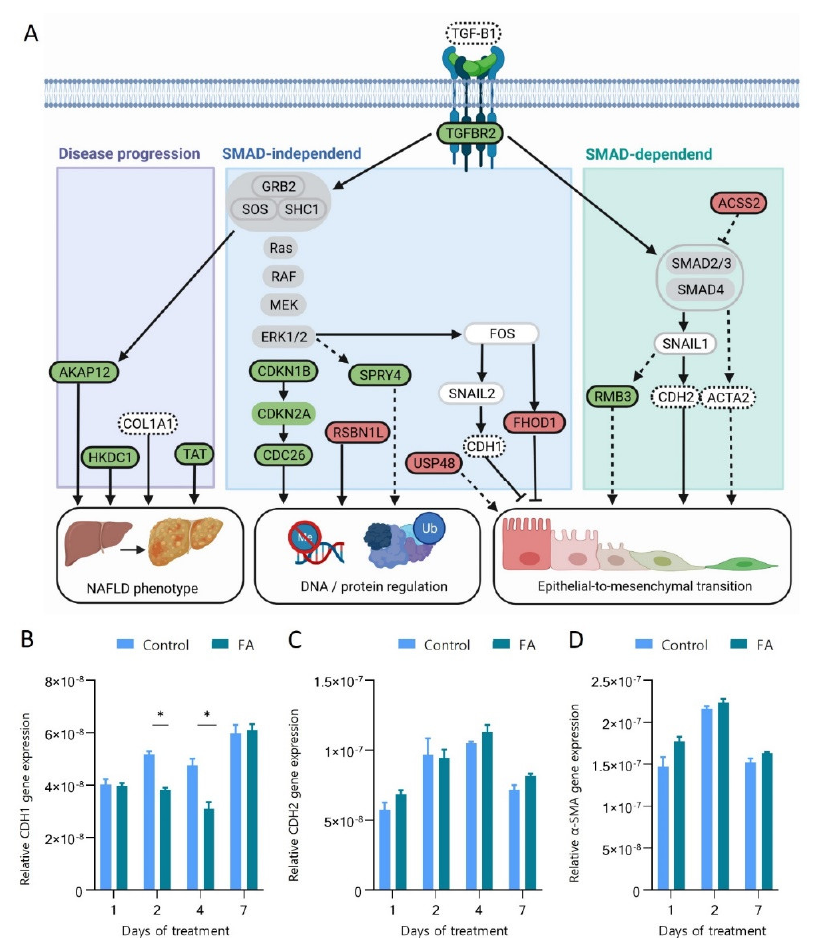
Figure 6. Signalling pathways and biological processes affected in spheroids treated with 45 µ M palmitic acid and 65 µ M oleic acid (FA) compared to the Control of standard growth media. ( A ) Summary of the dependencies between the significantly regulated proteins and their role in DNA and protein regulation, epithelial to mesenchymal transition and known markers of NAFLD phenotype in patients. The network was created using Ingenuity Pathway Analysis and BioRender tools. Circles indicate the following: Black-proteins significantly regulated FDR < 0.05; green-upregulated > 1.2-fold, red circles-downregulated > 1.2-fold, grey-not changing based on the proteomics data, white-not measured in this study, circled by dotted line-measured using qPCR. Full arrows indicate direct relation. Dotted arrows indicate indirect relations. Pointed arrows indicate activation. Blunt arrows indicate repression. Relative gene expression of ( B ) CDH1 (E-cadherin), ( C ) CDH2 (N-cadherin), and ( D ) a-SMA (alpha-smooth muscle actin) was measured by qPCR after 1, 2, 4 and 7 days of treatment. * statistically significant difference according to Student’s t-test and Holm–Sidak post hoc test, p < 0.05, n = 3. Error bars show the standard error of the mean.